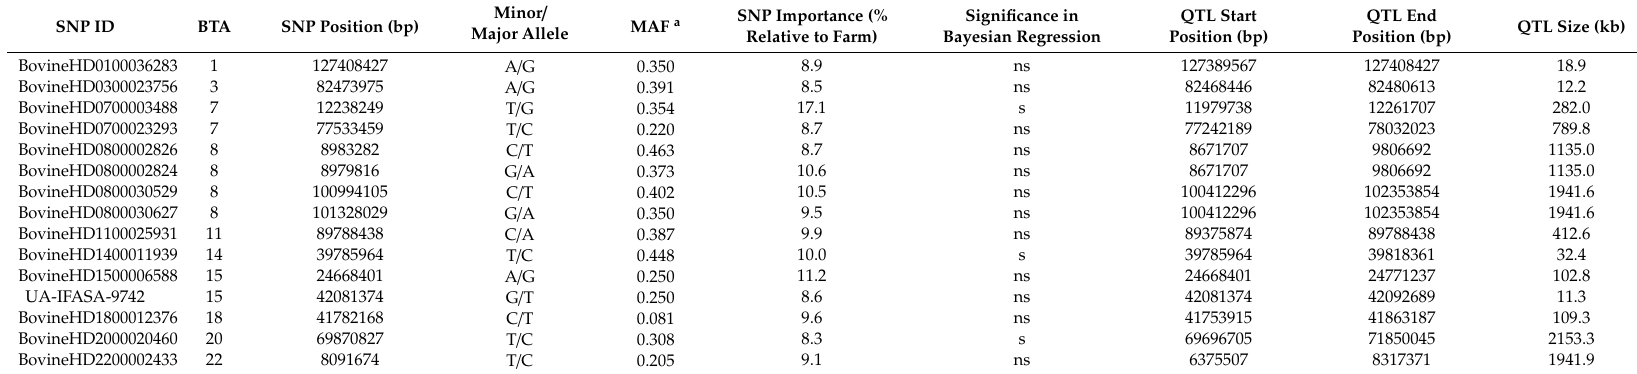
Table 5. Important SNPs from random forest analysis using quantitative phenotypes and their defined QTL. Importance variables are expressed as % importance relative to farm (i.e., farm had 100%